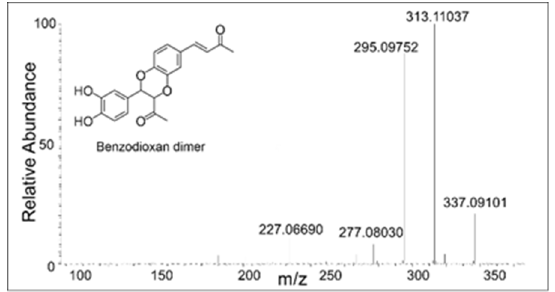
Figure 6. The collision induced decomposition (CID) mass spectrum of the m/z 355 mass unit ion eluting at 18 min. Its possible structure is indicated.